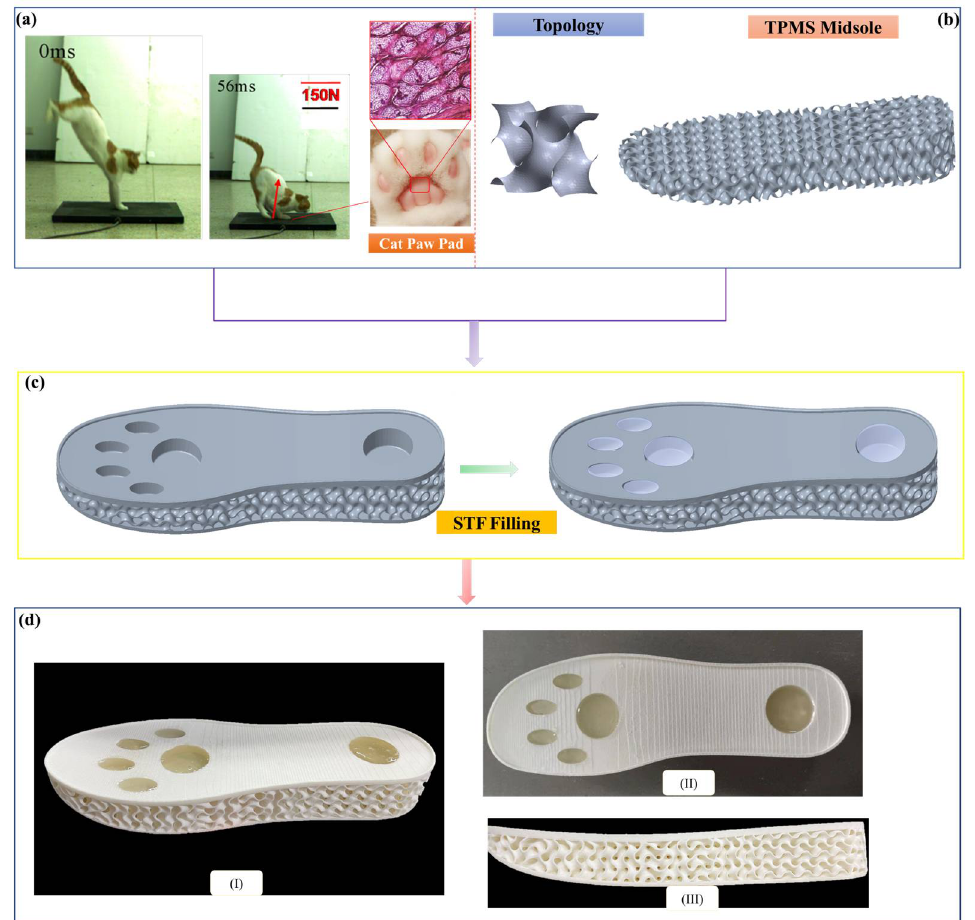
Figure 1. A bionic cushion sole design inspired by cat paw pads and TPMS: ( a ) image and microstructure of cat paw pads; ( b ) schematic diagram of TPMS midsole; ( c ) schematic diagram of sole with cat paw pad-shaped holes and TPMS midsole filled with STF; ( d ) cushion sole with different view orientations fabricated by additive manufacturing.